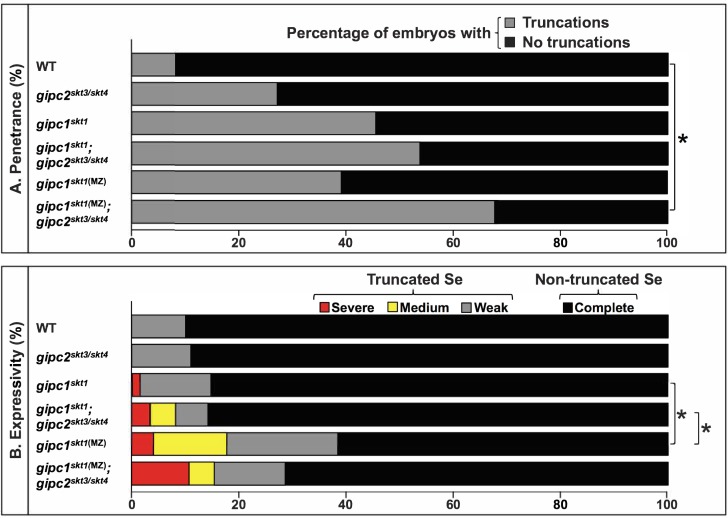
Penetrance and expressivity of Se truncations in gipc mutants at 32 hpf.(A) Penetrance bar graph. Percentage of embryos of the indicated genotypes with Se truncations (gray; a summation of the ‘severe,’ ‘medium,’ and, ‘weak’ categories) and with non-truncated Se (black; ‘complete’ category). Brackets and asterisks indicate pairs of genotypes with significantly different distributions of these two phenotypic classes as assessed by a two-sided Fisher Exact test, p<0.0033. (B) Expressivity bar graph. Percentage of ‘severe’ (red), ‘medium’ (yellow), and weak (gray) Se truncations and of ‘complete’ (black) non-truncated Se in embryos with Se truncations of the indicated genotypes. Brackets and asterisks indicate pairs of genotypes with significantly different distributions of the four phenotypic classes as assessed by a two-sided Fisher Exact test, p<0.0033. For additional supplementary information related to this figure, see Supplementary file 5. This figure is related to Figure 4.